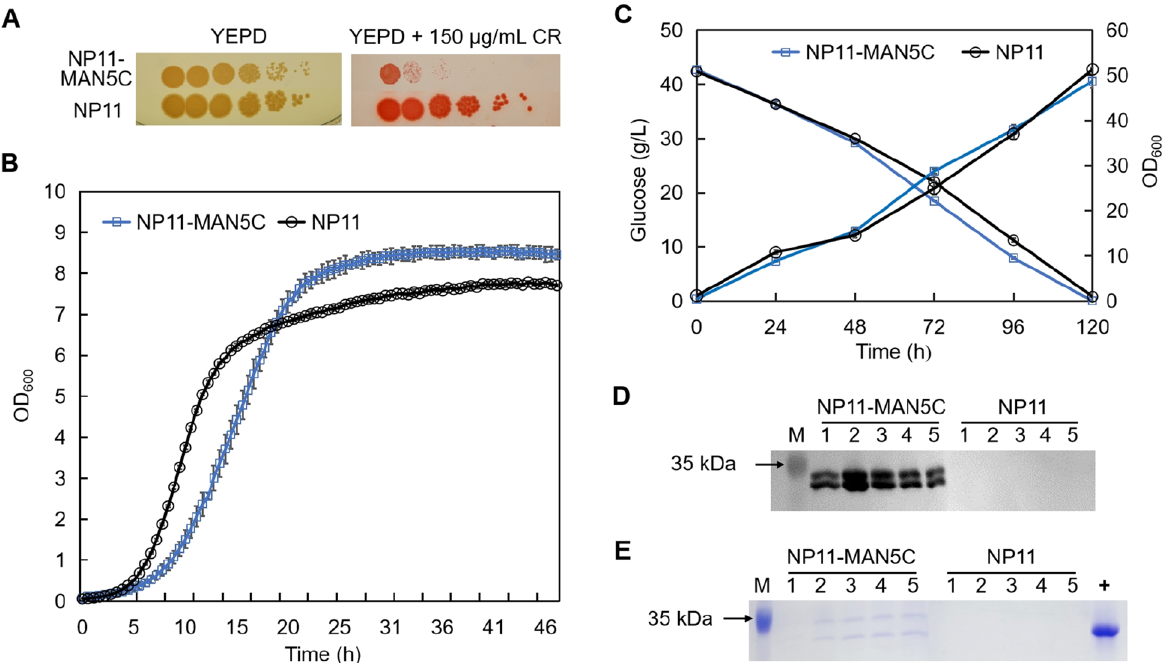
Fig. 3 Results of cell growth and MAN5C production. A Cell growth profiles on YEPD agar plate and that supplemented with Congo red; B Cell growth profiles in YEPD media at 30 ℃ , 800 rpm in a microbial growth analysis system; C Profiles of glucose consumption and cell growth in nitrogen-limited media at 30 ℃ , 200 rpm; D Western blot results of the supernatants of cell lysates; E SDS-PAGE results of the culture broth. Lane M: Marker; Lanes 1 to 5 were samples from the culture in nitrogen-limited media at 24, 48, 72, 96, and 120 h, respectively; Lane expressed by P. pastoris X-33